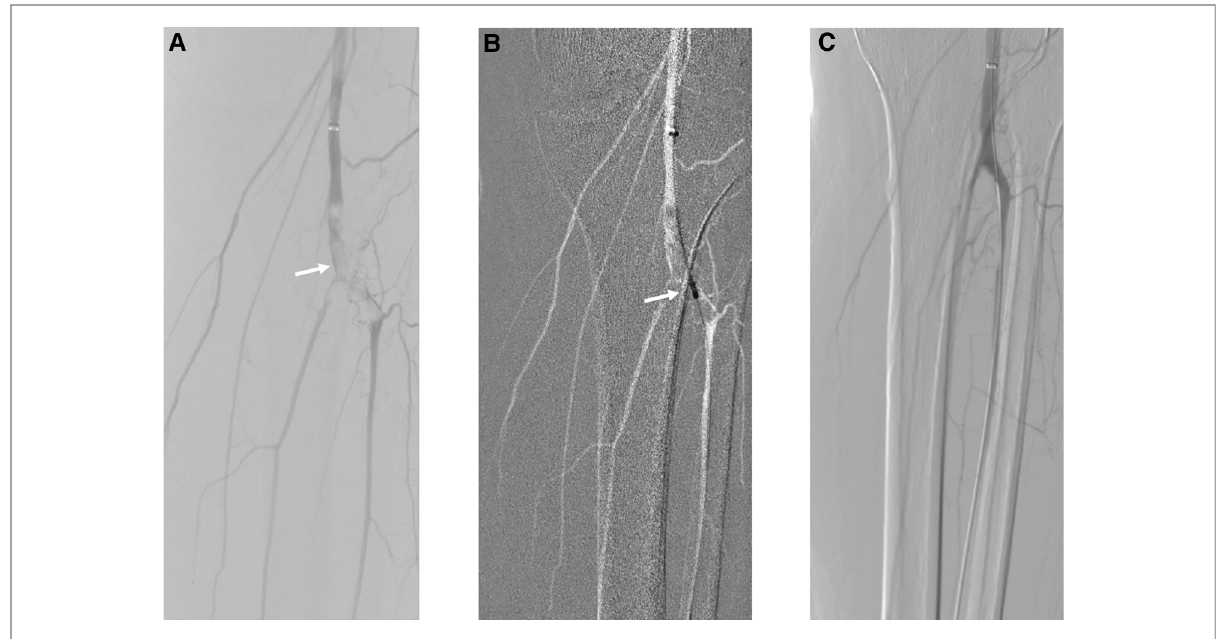
FIGURE 1 Acute embolism of popliteal and tibial arteries treated by mechanical thrombectomy with Rotarex S, PTA, and intraoperative urokinase. ( A ) White arrow points to the embolism of popliteal and tibial arteries. ( B ) PMT with Rotarex S under the roadmap. ( C ) Final result of recanalization after PTA and intraoperative